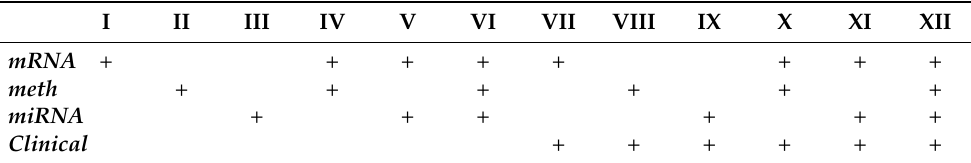
Table 1. Reference table for the twelve combinations of omics data analyzed in the study. For every omics set denoted by roman numerals, the ‘+’ sign implies the inclusion of the corresponding omics data